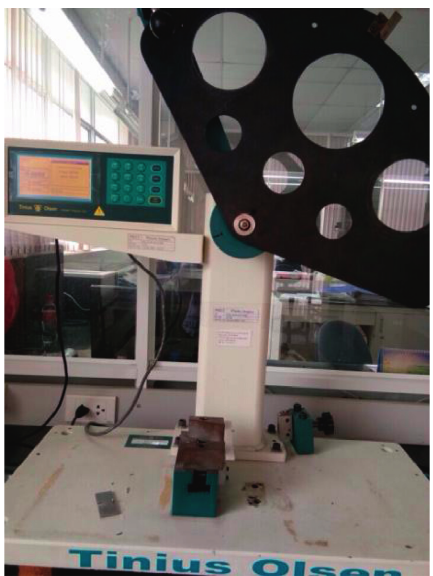
Figure 6: Izod impact tester Tinius Olsen IT504.